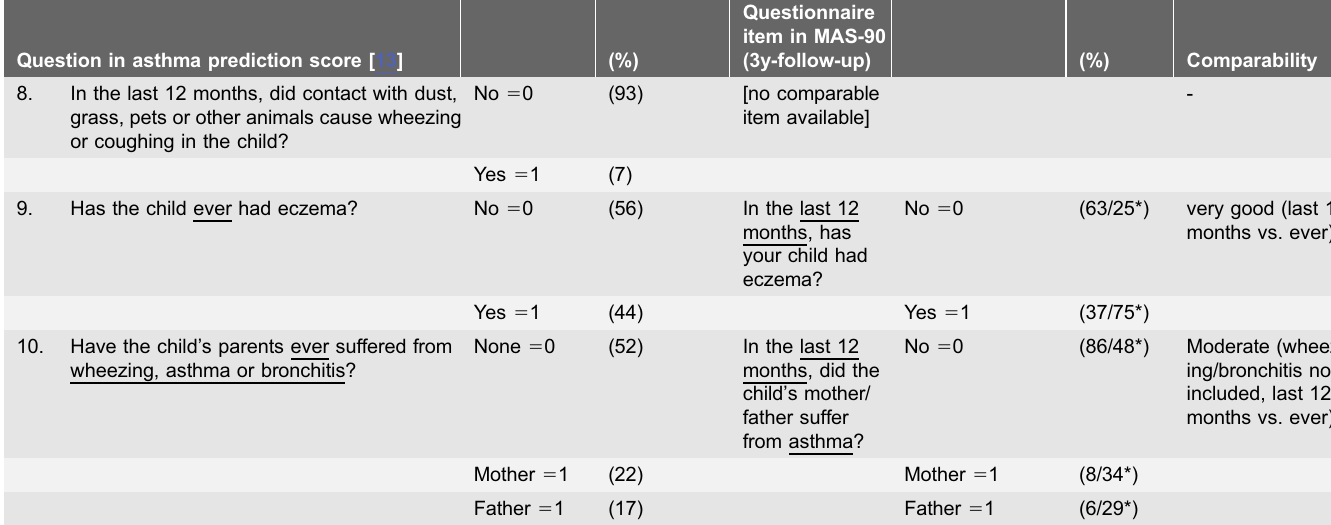
28 of 140 children (20%) who wheezed or coughed at 3 years of age met the primary outcome definition of asthma at 8 years (wheeze combined and asthma medication, both parent-reported). Regarding specific symptoms, 33 (26%) reported wheeze, 33 (26%) recent use of asthma drugs, and 27 (19%) a physician’s diagnosis of asthma. 51 of 121 children (42%) followed up to 20 years developed asthma between 3 and 20 years, the majority was sensitized to aero-allergens (84%). 29 of 93 (31%) participants at age 20 reacted to Methacholine challenge in lung function testing. In the low risk group (score # 5) asthma prevalence at 8 years was 9% (vs. 16% in original cohort), in those at medium risk (score 6–9) 45% (vs. 48%). Items used for inclusion and the primary outcome definition were comparable between the original and the validation cohort (table